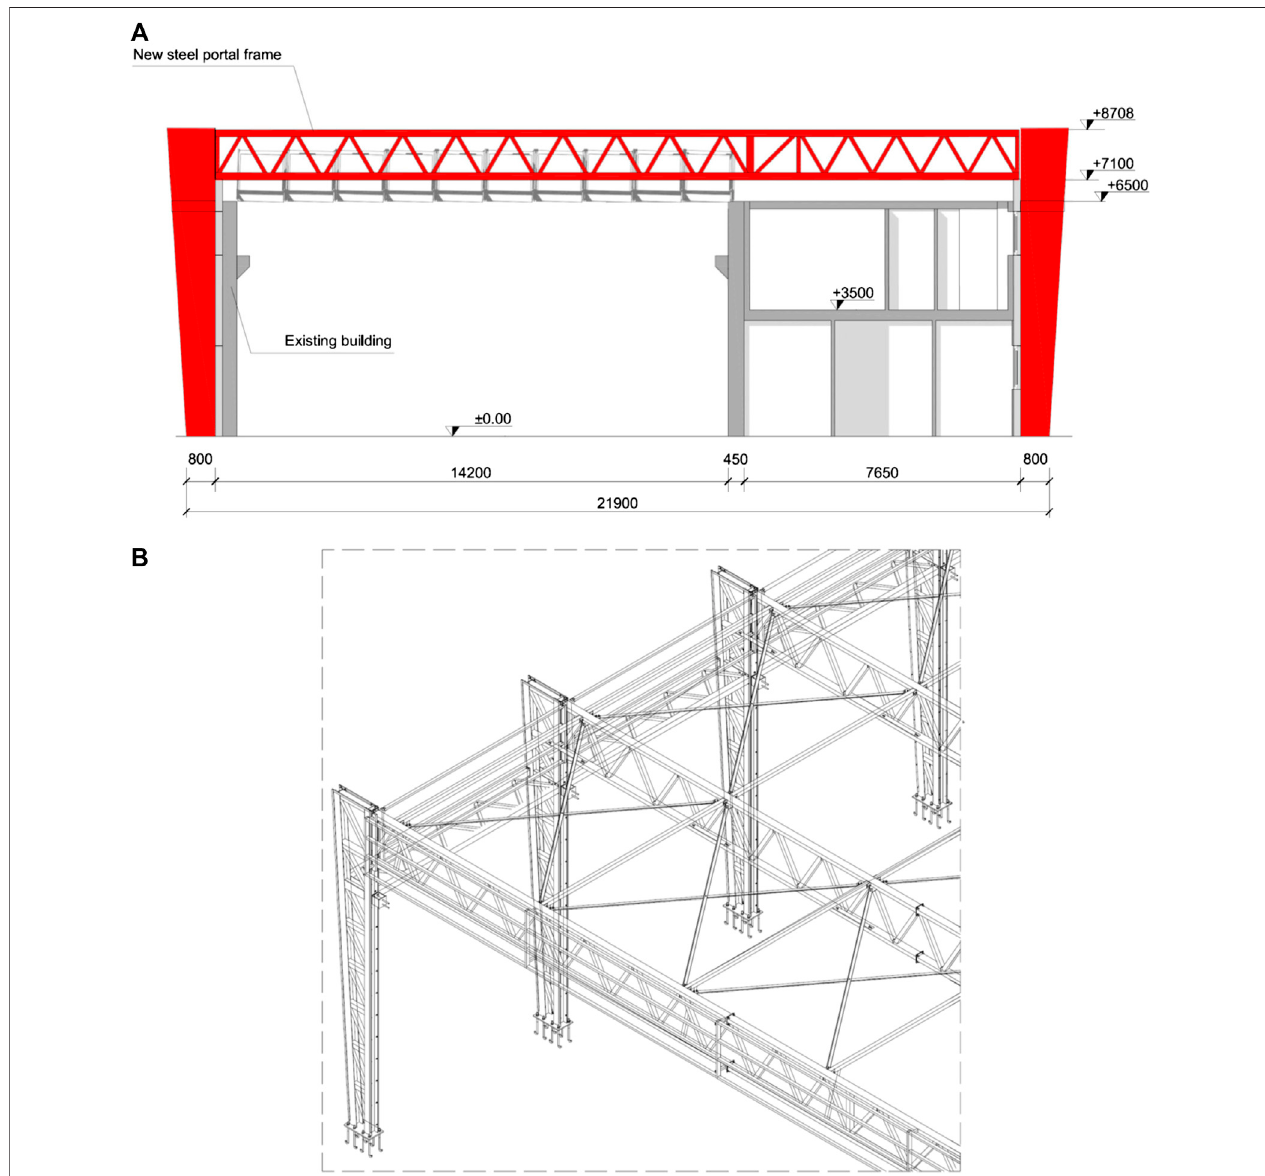
FIGURE 10 | Steel portal frames with laced built-up columns and truss beams used as earthquake resistant system at the outside of an existing precast building: (A) cross-sectional view of the building after the intervention; (B) three-dimensional view of the new steel structure. Dimensions in mm.